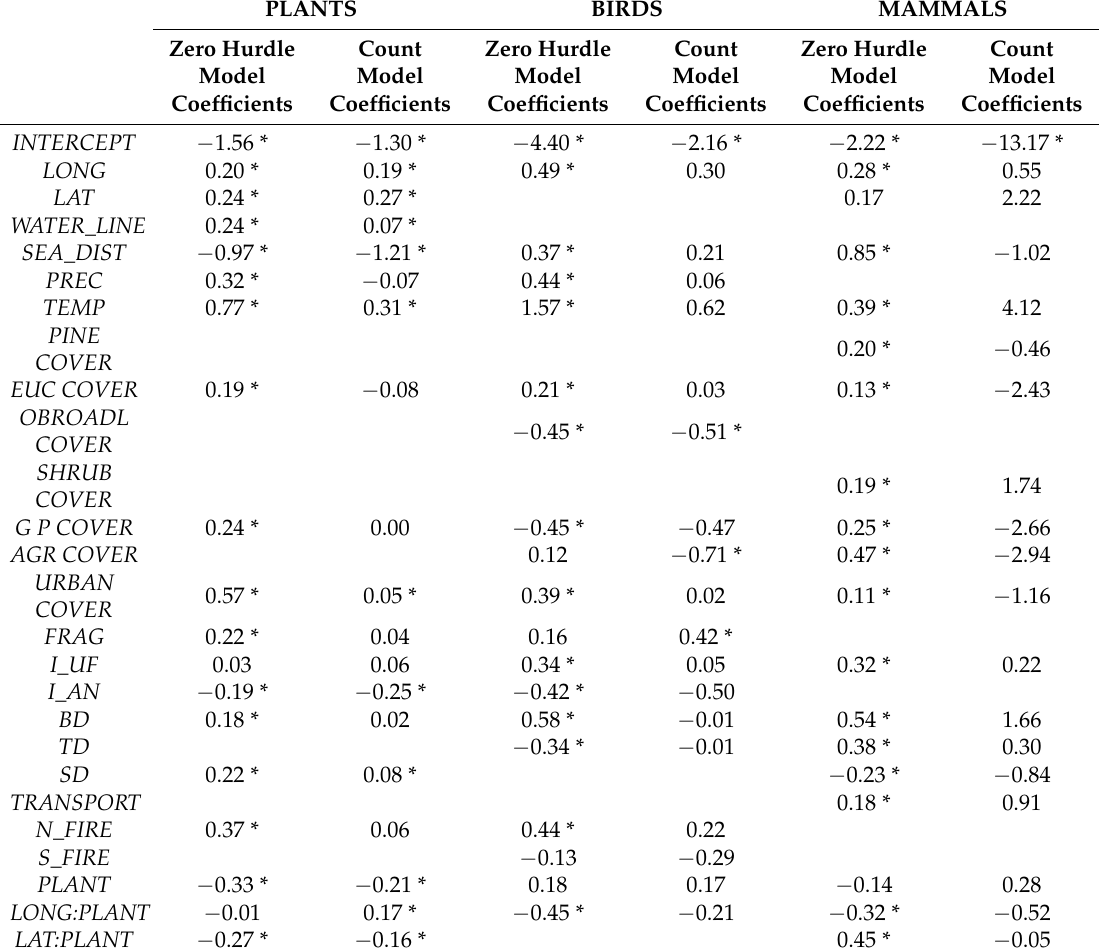
Table 3. Estimates, Standard error, and Significance of the Hurdle model fitted to invasive Plant, Bird, and Mammal species. PLANTS BIRDS